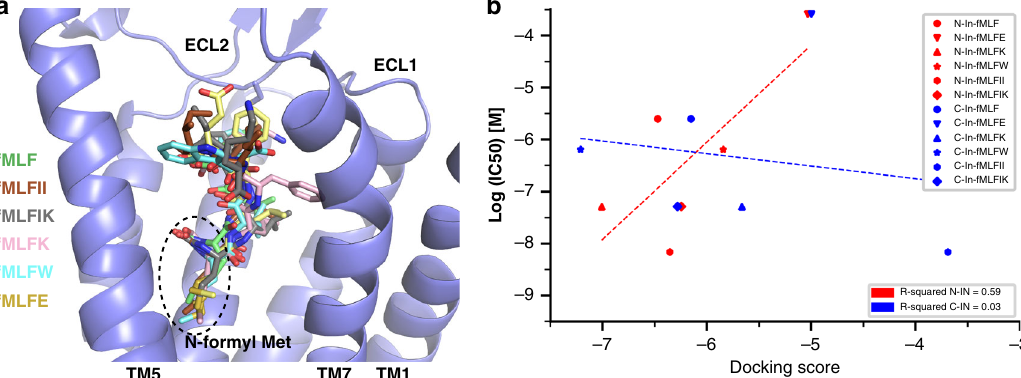
Fig. 3 Docking of formylpeptides to FPR2. a Binding poses of six formylpeptides in the N-ter-in mode in FPR2 (slate). The N-terminal formyl (N-formyl) Met residues are circled. b The computed glide docking scores for six formylpeptides in the N-ter-in (red) and C-ter-in (blue) modes are plotted against the Log (IC 50 ) values of them in the cAMP accumulation assays reported previously 40